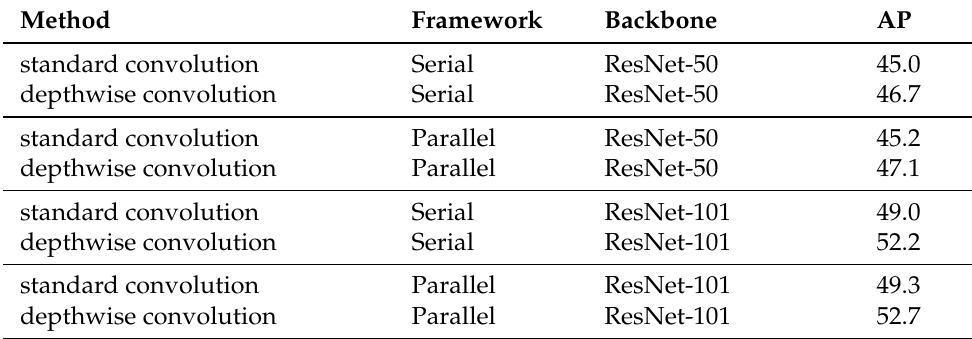
Table 1. Comparison between standard convolution and depthwise convolution under serial and parallel dual attention frameworks. The backbones we used are ResNet-50 and